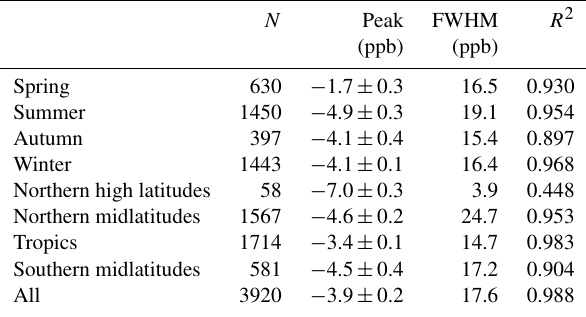
Table 1. Results for the Gaussian fit through the IASI-TES fre- quency distribution for different seasons and for different latitude bands. The latitude bands were separated by the polar circle and the Tropic of Cancer. Please note that TES measured only between 70 ◦ N and 50 ◦ S